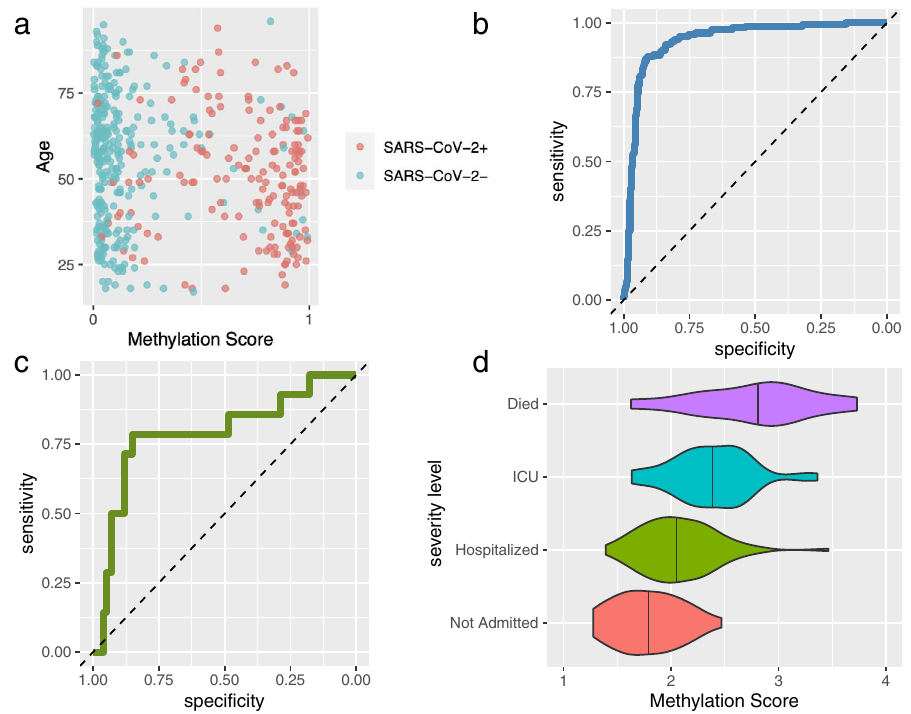
Fig. 4 Performance of SARS-CoV-2 infection status and severity predictive models. a Out-of-sample case – control methylation score for all 460 individuals (164 SARS-CoV-2 + , 296 SARS-CoV-2 − ) compared to case – control status, plotted by biological age. b Receiver-operating characteristic (ROC) curve for data in a . c ROC curve of cross-validated prediction of long hospital duration. d Violin and jittered scatter plots of severity methylation scores for each outcome in cases. Data used to plot this fi gure are available as Supplementary Data